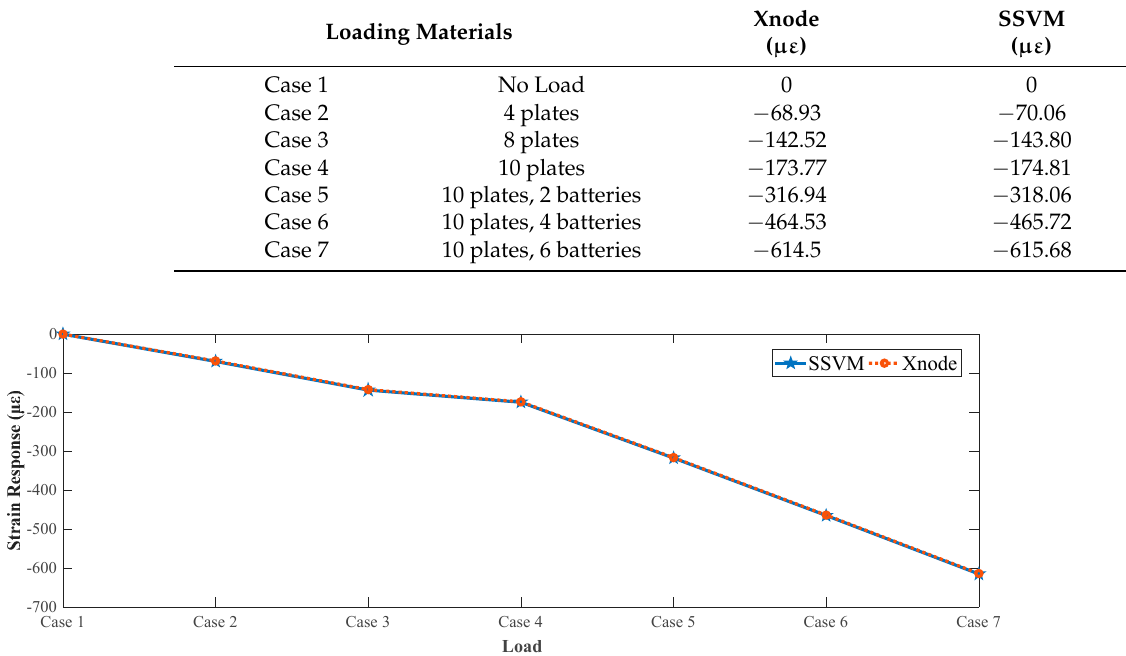
Table 3. Comparison between Xnode and SSVM.